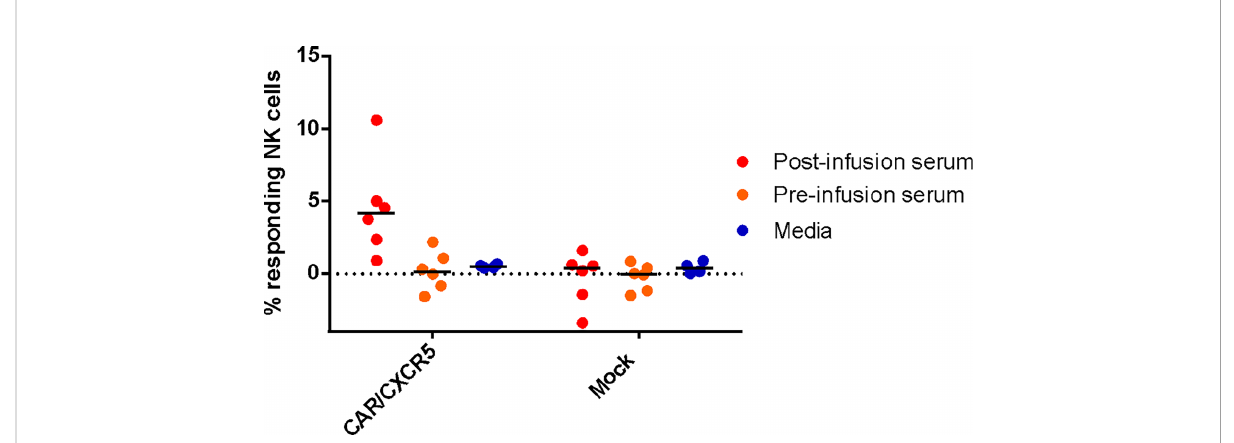
FIGURE 4 Anti-CAR antibodies bound to CD4-MBL CAR/CXCR5 cells induce antibody-dependent cellular cytotoxicity by NK cells. The percent of responding NK cells measured by the frequency of CD107a+ NK cells after co-culture with indicated serum (media n = 4, post-treatment n = 6, and pre-treatment serum n = 6) and target cell type (CD4-MBL CAR/CXCR5 or mock). Bars are drawn at the mean.